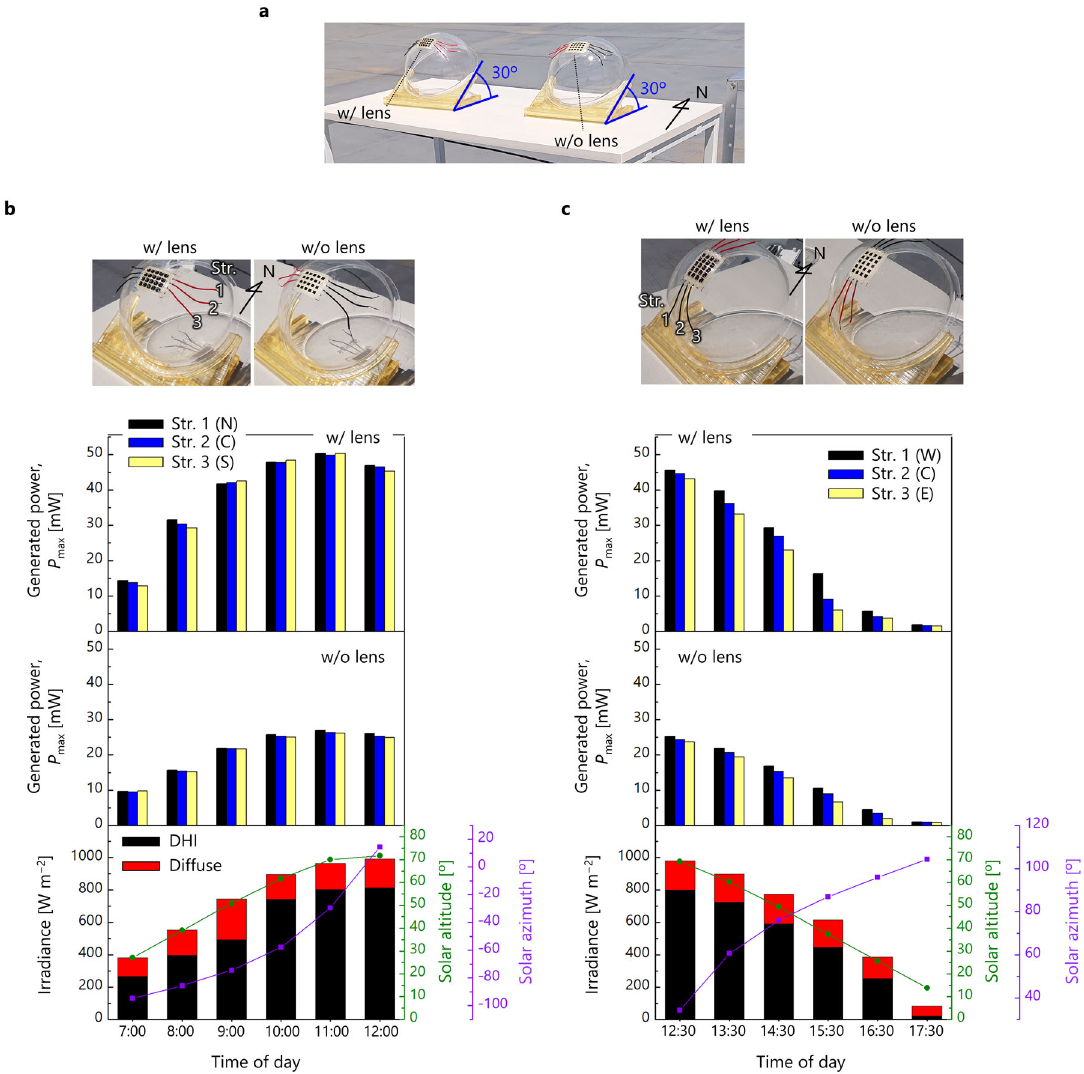
Fig. 5 Outdoor power-generation performance at representative times (prototype modules atop the hemispherical domes were installed on a 30°- inclined surface). a Magni fi cations of the prototype modules in the experimental setup. b , c Measured P max and irradiances (direct horizontal irradiance (DHI), diffuse irradiance) as a function of the sun ’ s position on May 19, 2019 (Nagaoka city, Japan). The string directions were ( b ) east – west in AM and ( c ) north – south in PM. String 1 lay on the northern side in AM (black bar referred to as “ N ” ) and on the western side in PM (black bar referred to as “ W ” ); string 2 lay on the center line of the hemispherical dome (blue bar referred to as “ C ” ); and string 3 lay on the southern side in AM (yellow bar referred to as “ S ” ) and on the eastern side in PM (yellow bar referred to as “ E ” ). For the solar altitude, 90° corresponded to the zenith, and for the solar azimuth, − 90°, 0°, and 90° corresponded to east, south, and west, respectively. (w/ lens, with lens; w/o lens, without